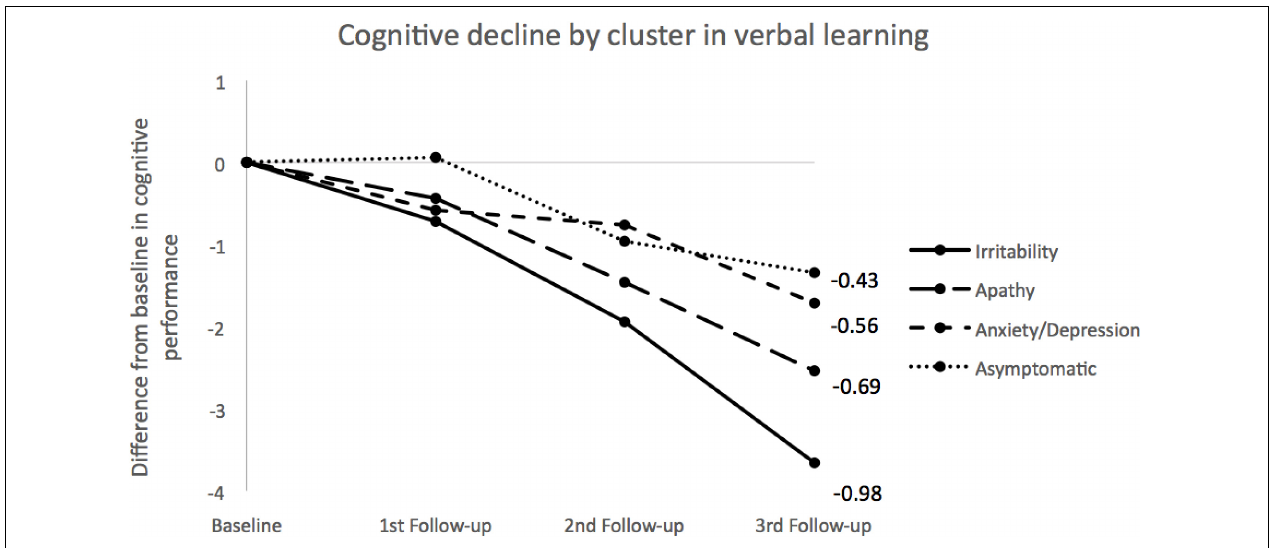
FIGURE 1 | Cognitive decline across clusters for verbal learning. Measures for each group were obtained using LMM means by calculating differences between baseline and follow-ups for each time point. Slopes for each cluster were calculated using the 2-known points approach. Negative values correspond to decrements: the larger the absolute values the steeper the line. Numbers at the end of the lines indicate the cognitive slopes for each class.